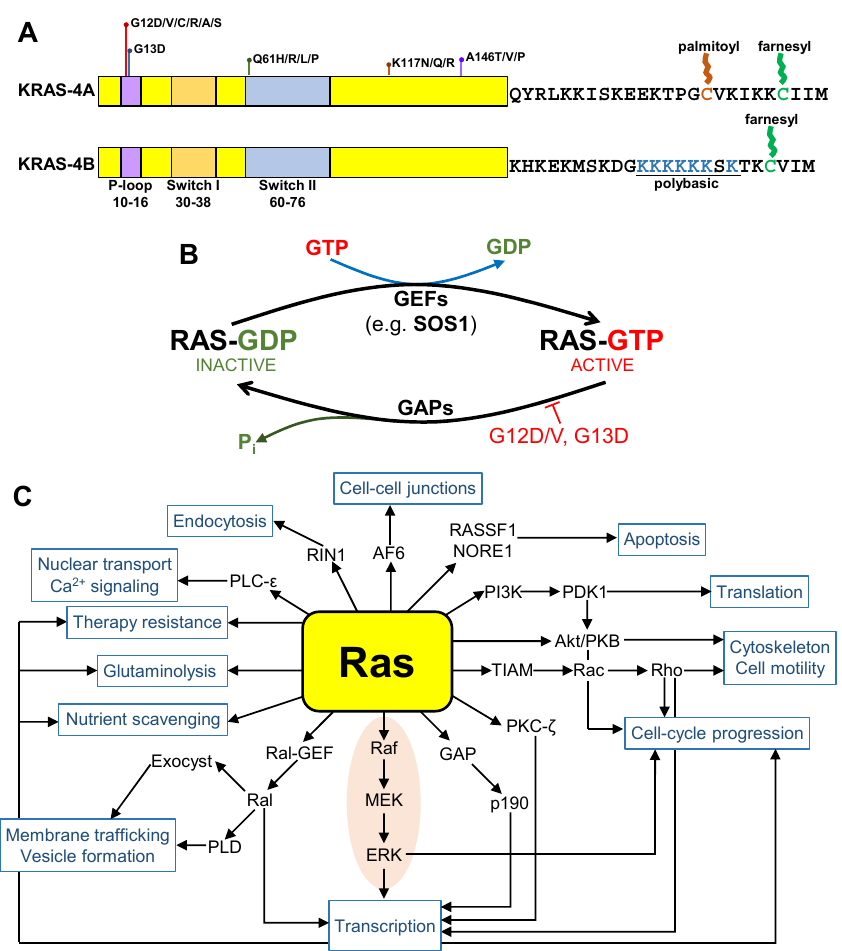
Figure 1. Protein domains of KRAS-4A and KRAS-4B. KRAS-4A and KRAS-4B differ in the C-terminal amino acid sequence ( A ). A simplified diagram of Ras GDP and GTP cycling into inactive and active states. ( B ) Simplified diagram showing the plethora of downstream pathways Ras activates ( C ) The RAF/MEK/ERK pathway is highlighted (orange background). Targeting the ERK and/or AKT pathways alone may not be sufficient.